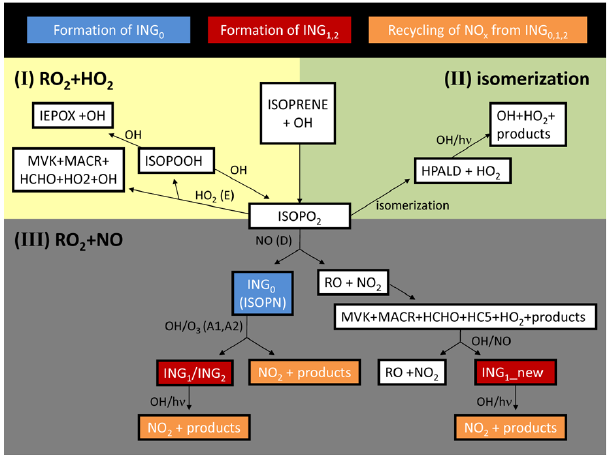
Fig. 1a. Updated oxidation scheme for isoprene + OH, noting the formation of first generation isoprene nitrates (ING 0 ) , later genera- tion isoprene nitrates (ING 1 , 2 ), and recycling of NO x from isoprene nitrates. Reactions modified by the sensitivity studies in Sect. 3.4 are denoted by the letters in parentheses (A–E).